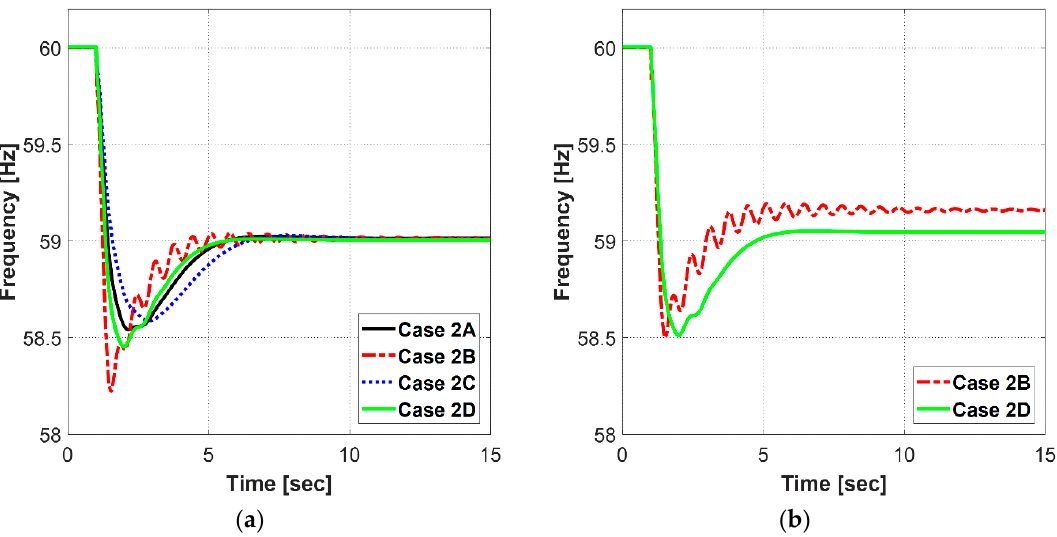
Figure 7. Frequency responses with ESS: ( a ) after credible contingency based on the QSS frequency (Cases 2A–2D); ( b ) after credible contingency based on the instantaneous frequency (Case 2B and 2D).